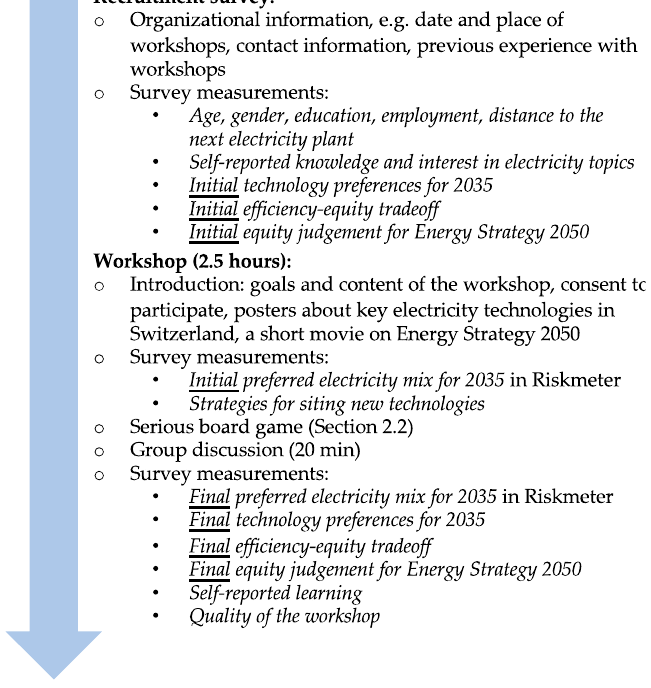
Figure 1. Overall process and the survey measurements (in italic ). The underscored text indicates the measurements that were repeated before and after the game.